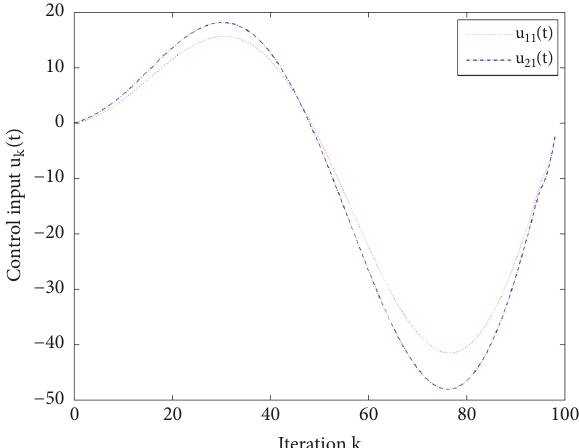
Figure 4: For 𝑡 ∈ {0, 1, .. ., 𝑁 𝑘 } , the control input trajectories of the ILC system (27) at iterations 𝑘 = 11 and 𝑘 = 21 .